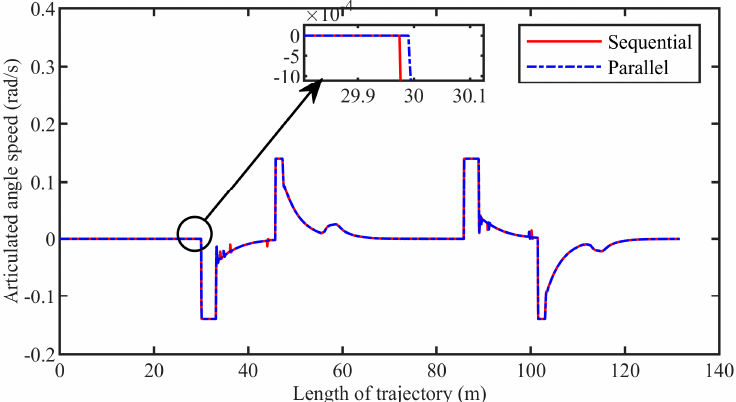
Figure 14. Articulated angle speed of the comparison between calculation processes.